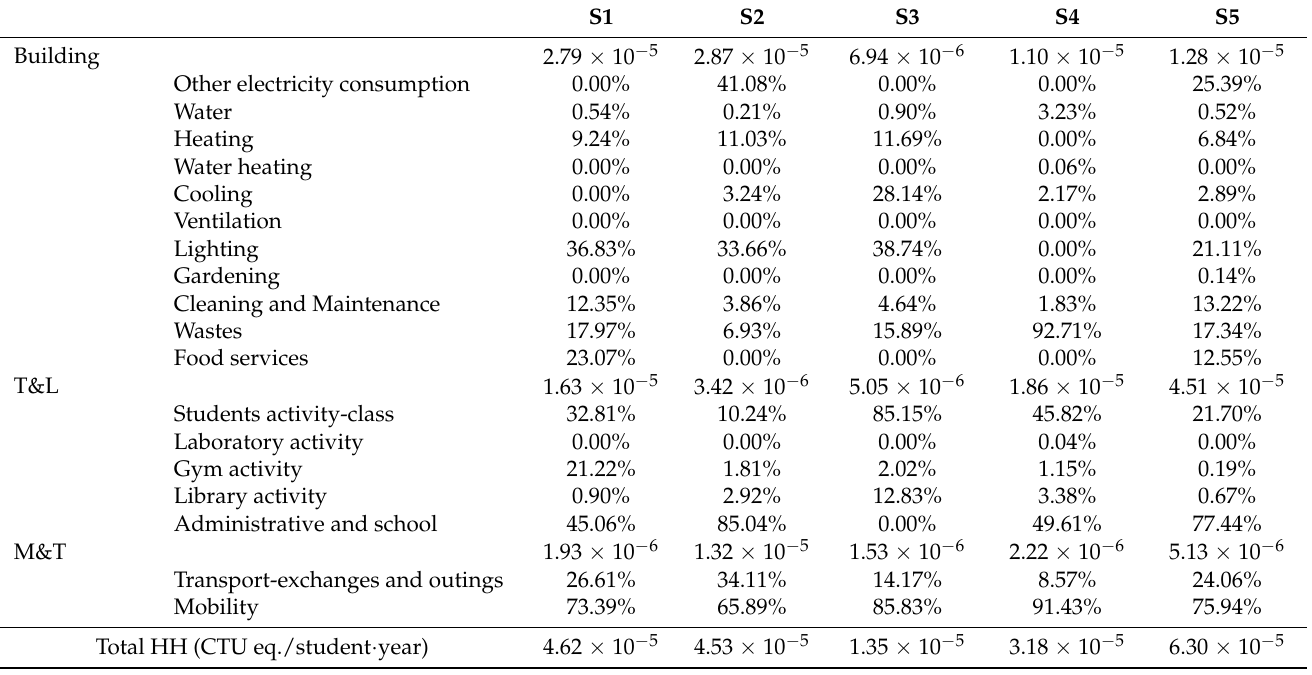
Table 9. Human health (HH) impacts results per school, subsystem, and activities.